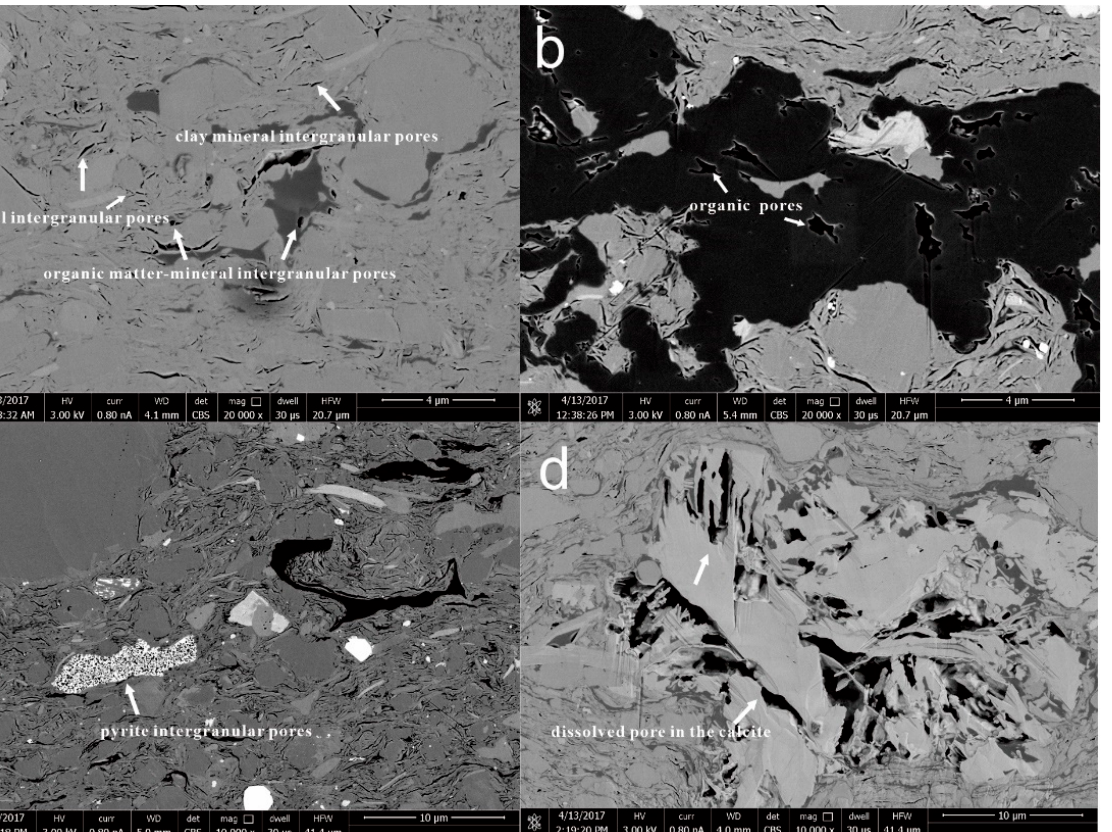
Figure 2. Pore types of shales by SEM in K 2 n 1+2 , Songliao Basin. ( a ) Mudstone sample at 1082.4 m; ( b ) shale sample at 978.2 m; ( c ) mudstone sample at 1052.1 m; ( d ) mudstone sample at 1127.8 m. Low-pressure N 2 adsorption is an effective method to analyze the nanopore of shale [55,57–62]. The samples were ground to a 40–80 mesh powder (~178–425 µ m particle size) and dried at 110 ◦ C for 8 h to remove any adsorbed moisture and volatiles.